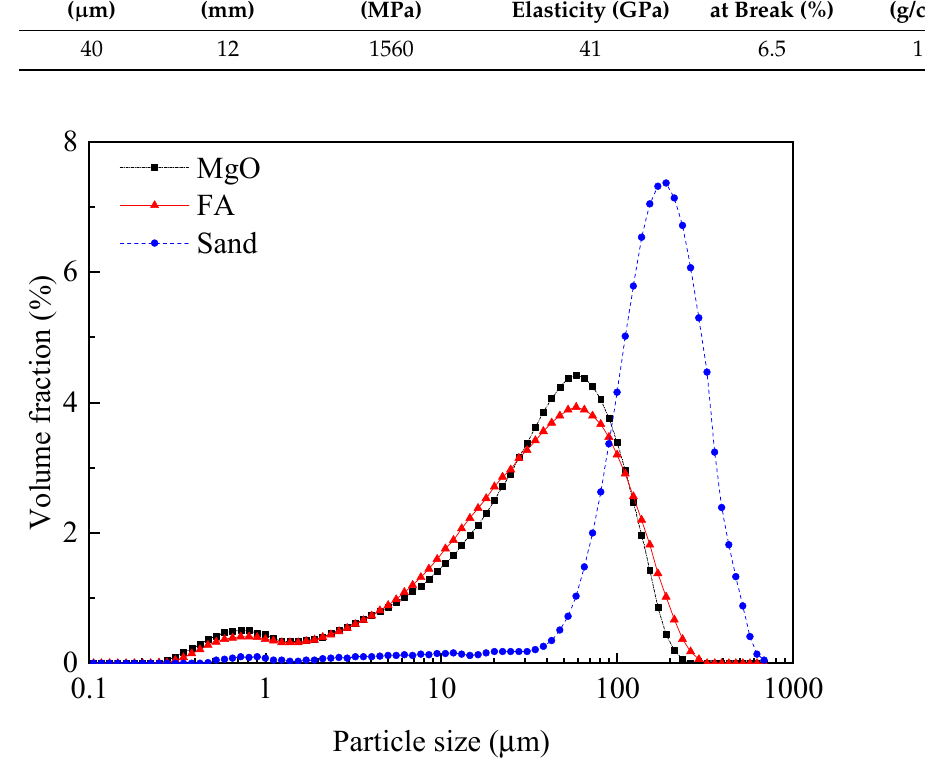
Figure 1. Particle size distribution of MgO, FA, and quartz sand.